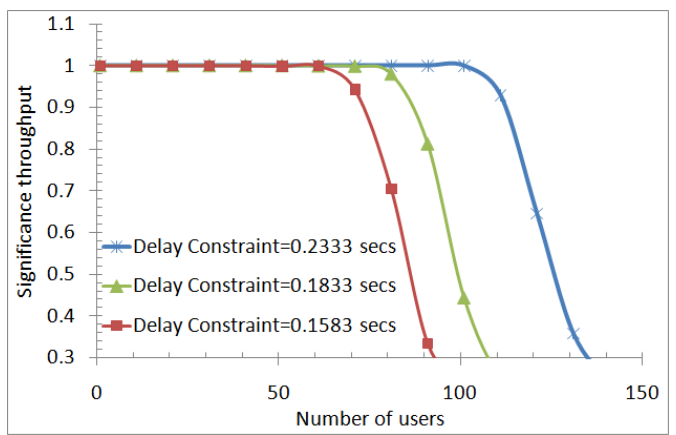
Figure 8. Significance throughput versus number of users for different maximum delay constraints, 100% of users and α = 0.